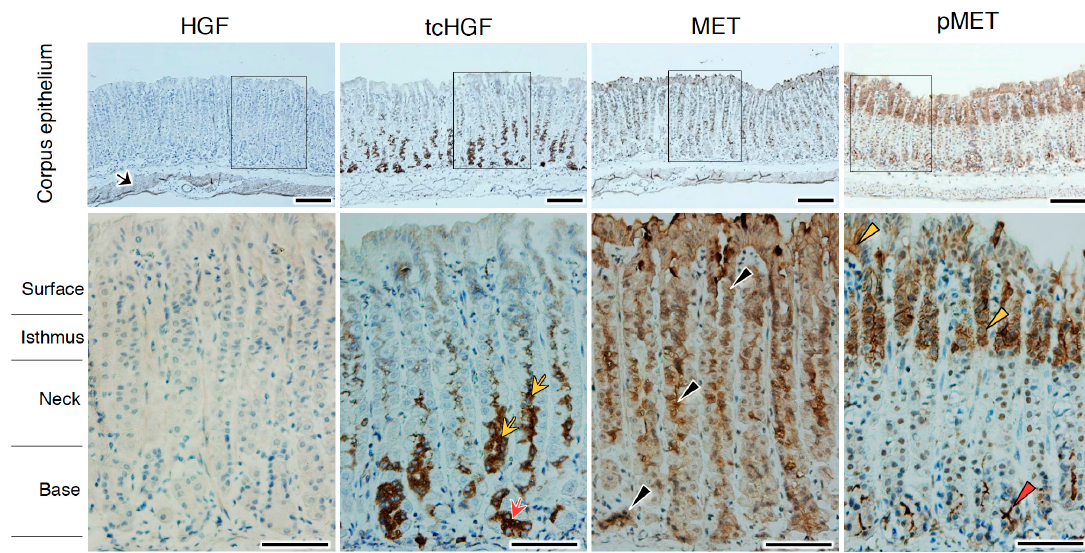
Figure 5. Localizations of HGF, tcHGF, MET, and pMET in the corpus epithelium of the adult stomach. Immunohistochemical staining was performed using t5A11 (for scHGF and tcHGF), t8E4 (for tcHGF), anti-MET, or anti-phospho-MET antibody. Black arrows, HGF in smooth muscle cells; red arrow, tcHGF in the glandular base region; yellow arrows, tcHGF in the neck region; black arrowheads, MET in glandular epithelial structure; red arrowhead, pMET in the glandular base region; yellow arrowhead, pMET in the isthmus region and the surface region. The images in the lower panel are magnified images of the boxed areas in the upper panel. Similar immunohistochemical localization patterns were obtained in sections from two different mice. Tissues were obtained from hHGF-ki mice. Scale bars represent 200 µm.